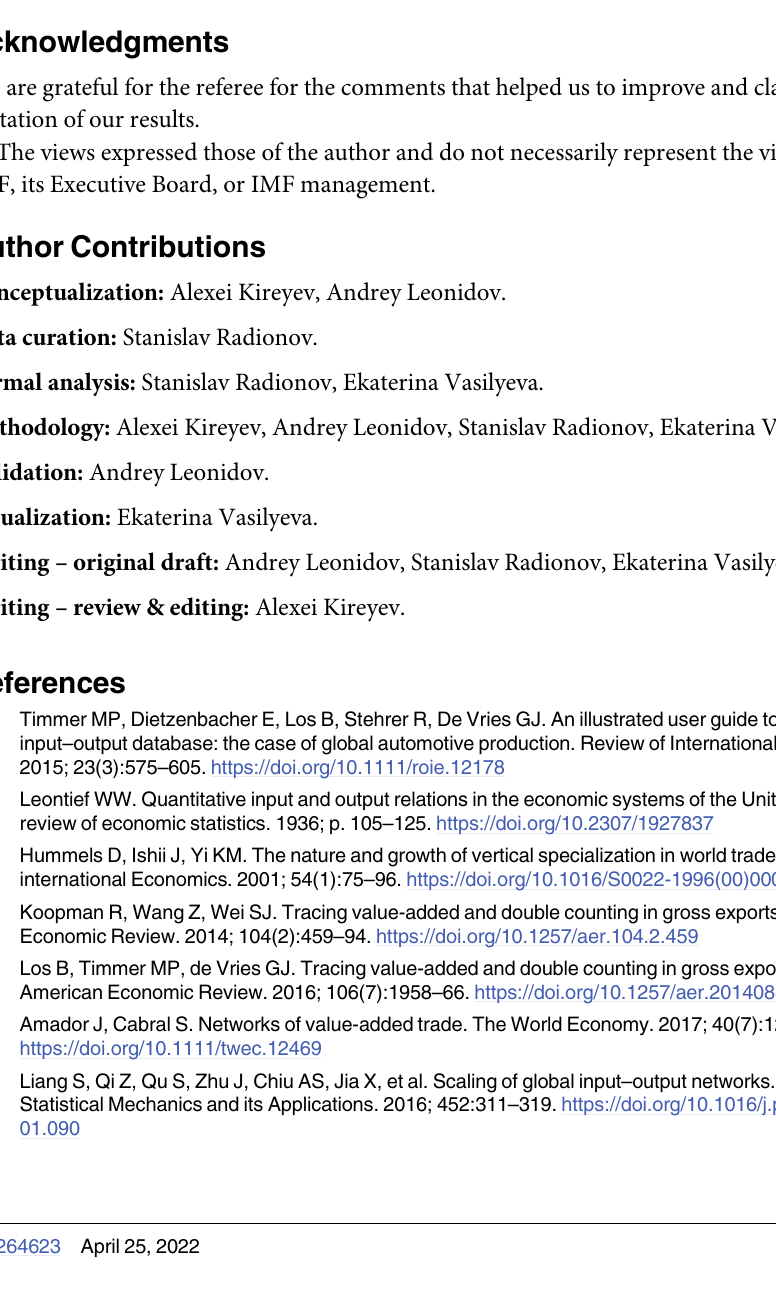
S1 Table. Range of modularity values in the results of different algorithm calls. S2 Table. Types of initial distributions used in the calls resulting in the main partitions. S3 Table. ISO country